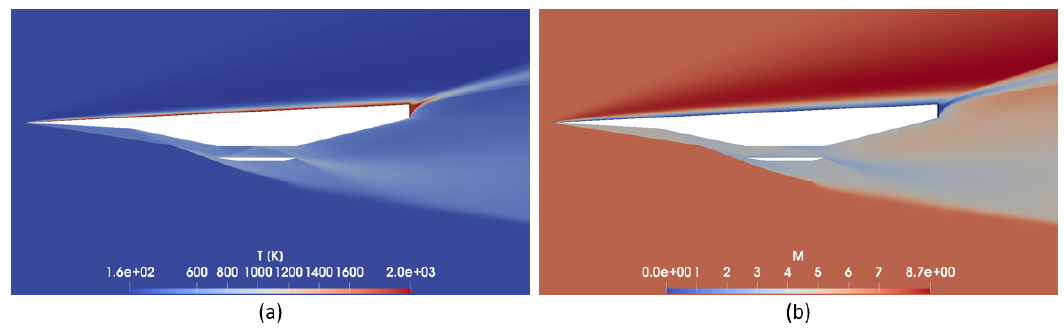
Figure 12. Pressure field ( a ) and density field ( b ) of case 1 for AoA = 14 ◦ .